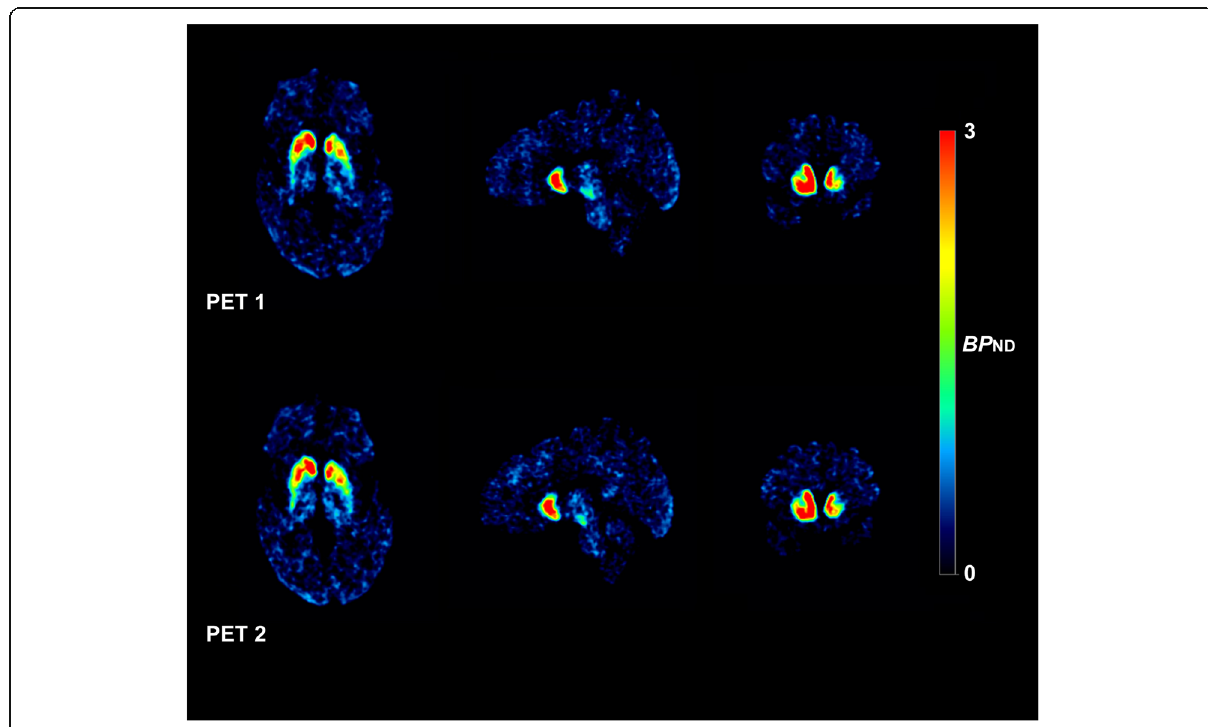
Fig. 1 Representative test and retest parametric BP ND images of [ 18 F]FE-PE2I